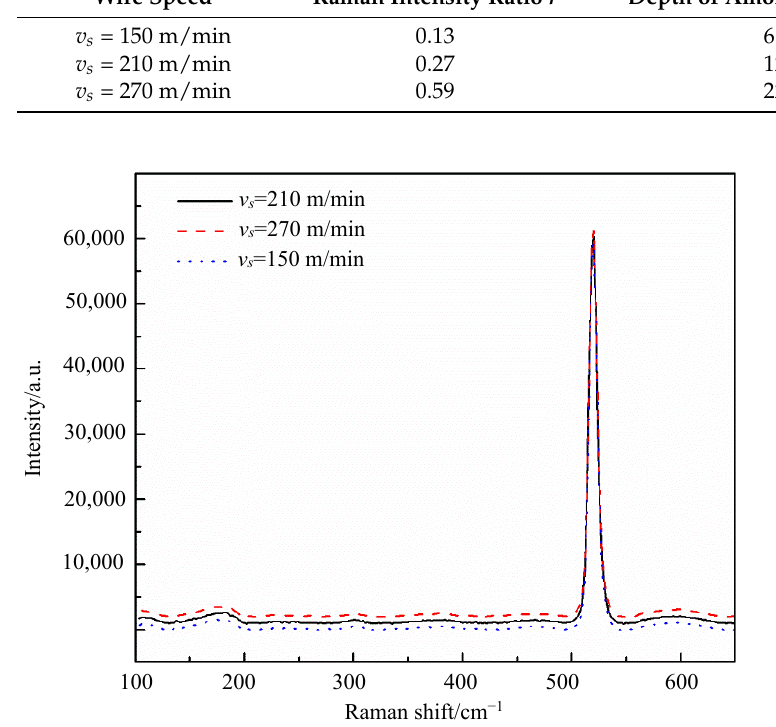
Figure 7. The Raman spectrum of wafers sawn by different wire speeds. Table 2. The ratio r and depth of amorphous silicon layer for three kinds of sawn silicon wafers. Wire Speed Raman Intensity Ratio r